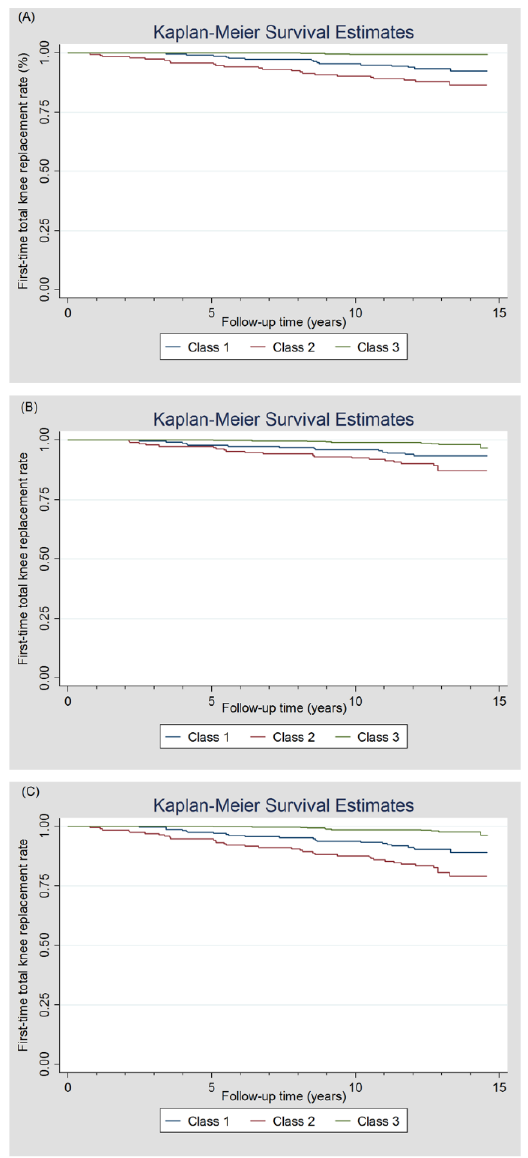
Table 2. Details of first-time total knee replacement across three pain phenotypes.